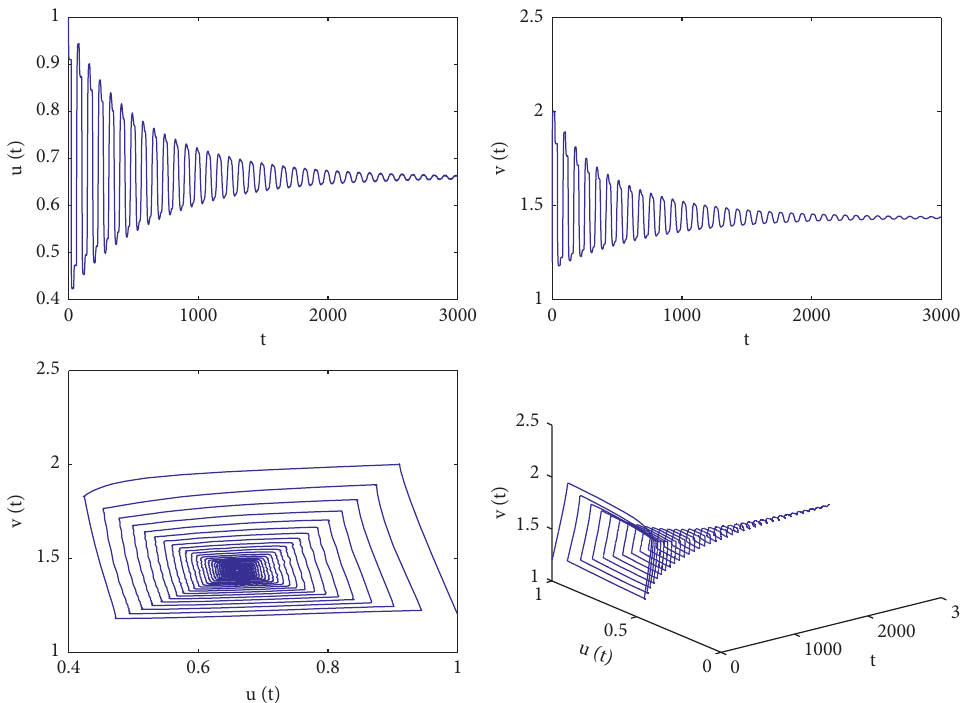
Figure 2: The trajectories graphs and phase graphs of system (93) with τ